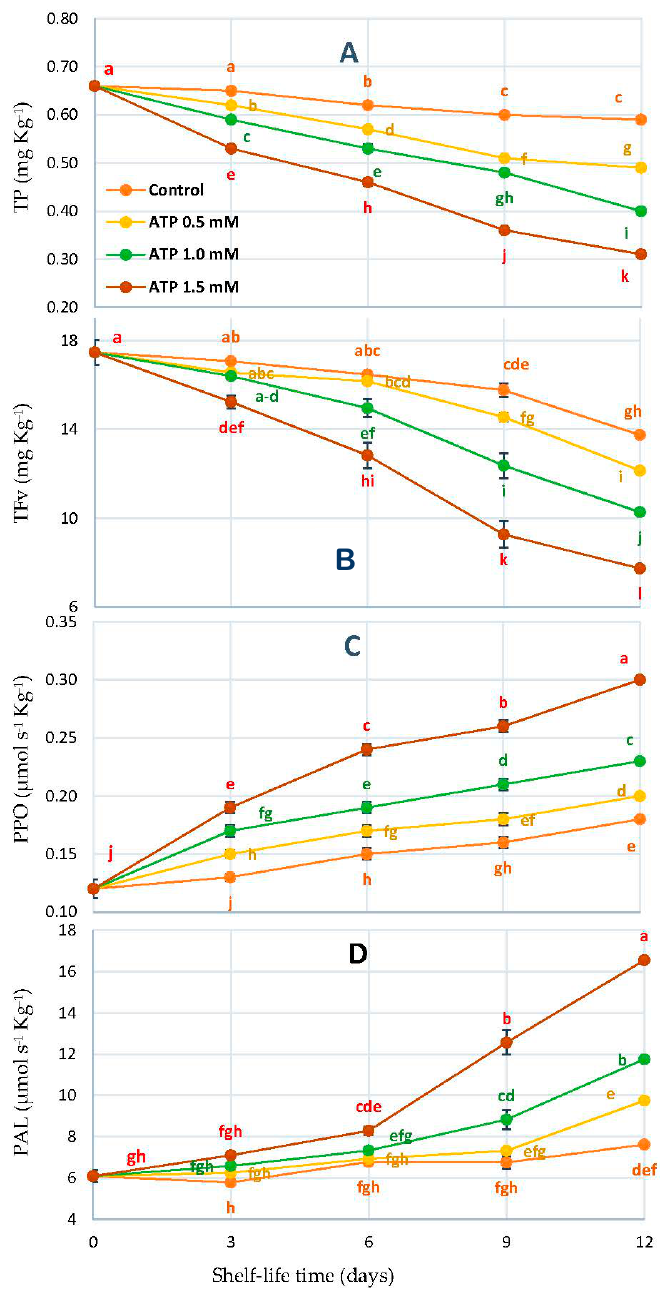
Figure 5. TP ( A ), TFv ( B ), PPO ( C ), and PAL ( D ) of ‘Zaghloul’ date fruit treated with ATP at different concentrations (0, 0.5, 1.0, and 1.5 mmol L − 1 ) during storage at 27 ± 1 °C, 67 ± 3% R, for 12 d. Each value represents mean ± SE ( n = 3). The letters differ ( p < 0.05) and represent the significance between treatments using the Tukey–Kramer HSD test to compare the different